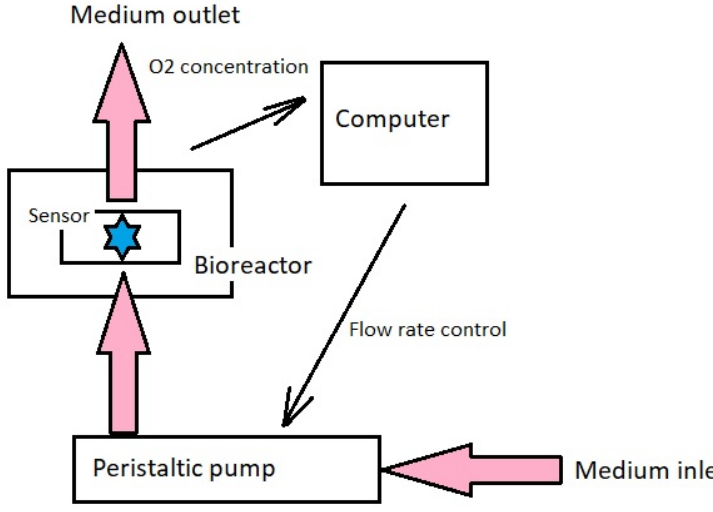
Figure 9. System providing medium flow in a culture bioreactor.